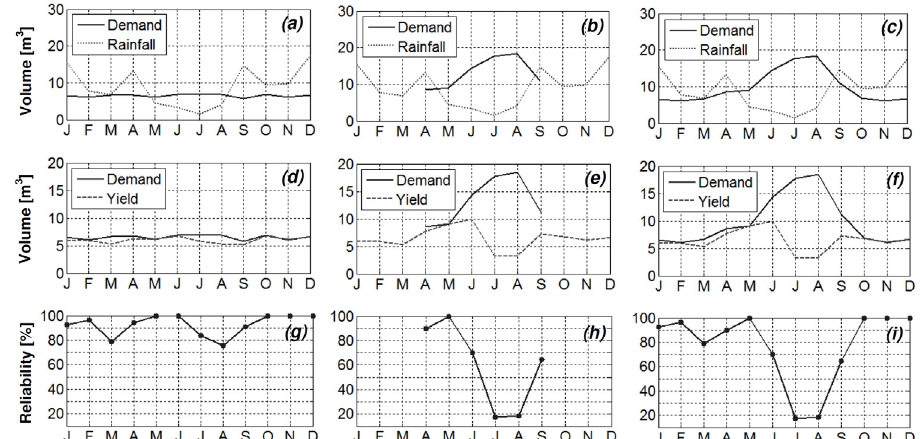
Figure 6. Monthly water demand, rainfall volume and yield, and monthly variation of system reliability for toilet flushing ( a , d , g ); garden irrigation ( b , e , h ); and both uses ( c , f , i ).